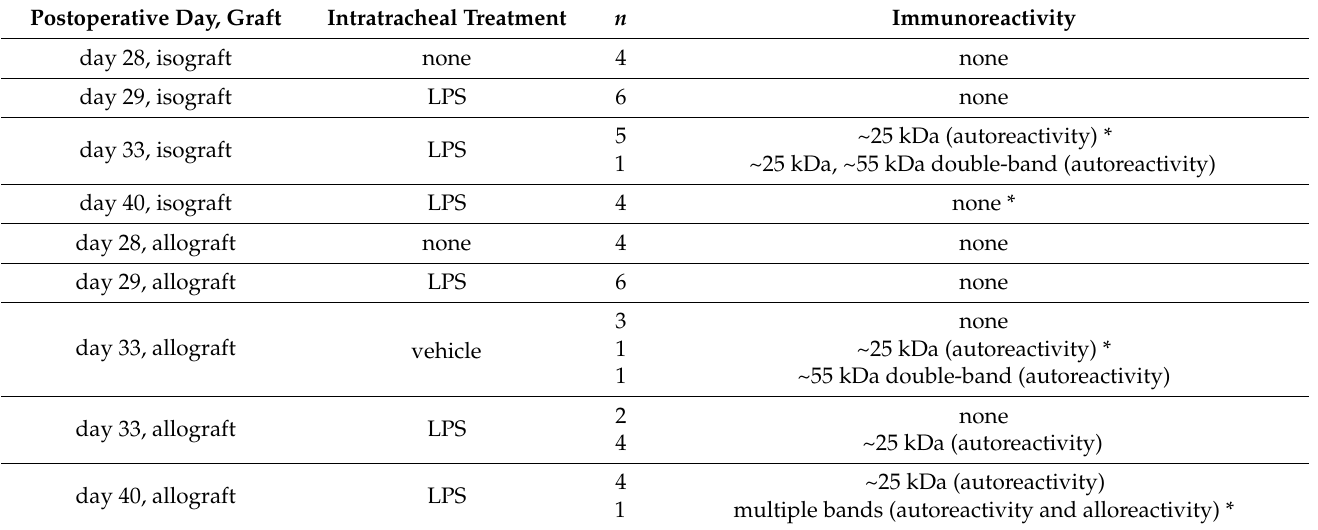
Figure 6. Immunoreactivity of sera from lung transplant recipients on Western blots of protein extracts of native Fischer-344 (F) and Lewis (L) rat lungs. Representative examples showing immunoreactivity of IgM ( a ) and IgG ( b ) of sera from native Lewis rats (L) and isogeneic (iso) or allogeneic (allo) lung transplant recipients on postoperative days 33 (d 33) and 40 (d 40), 5 and 12 days after treatment with LPS, respectively. Arrows indicate molecular masses: 75 kDa, 50 kDa, 25 kDa in top to bottom order. Table 1. Immunoreactivity of IgM of sera from lung transplant recipients on Western blots of protein extracts of Lewis and Fischer-344 rat